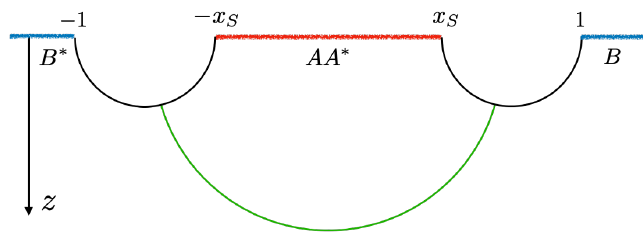
Figure 9 . The bulk solution for the Schottky domain. Only a slice directly below the boundary real line is shown. The green line is the RT surface for region AA ∗ . To achieve the minimal condition the green line must meet both the circles at a perpendicular